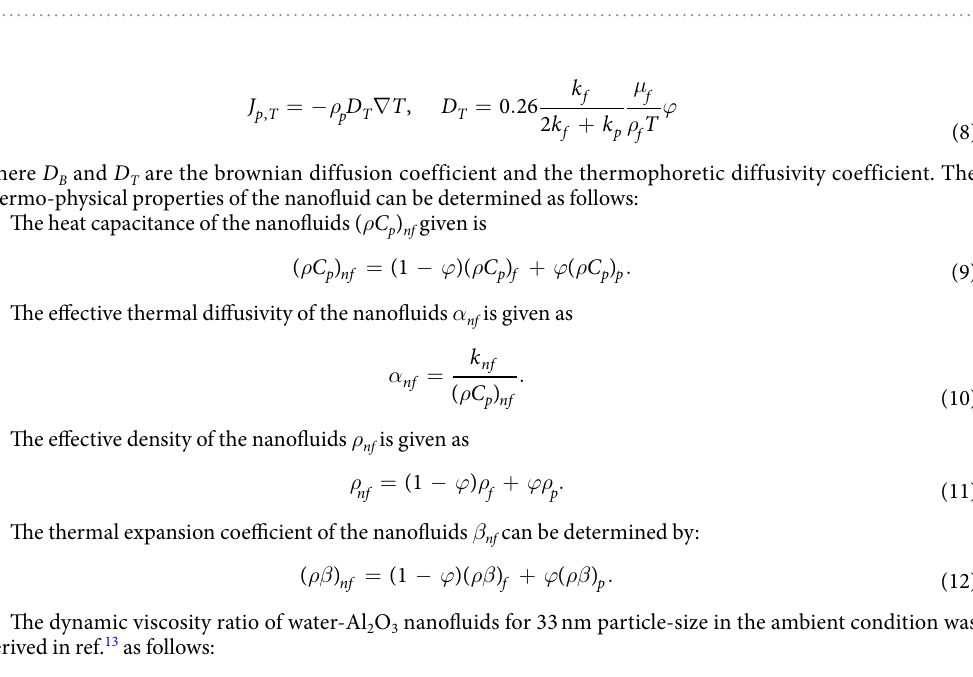
Figure 12. Variation of average Nusselt number with ( a ) Ra and ( b ) D for different φ at Ha = 15, k w = 0.76 and D =